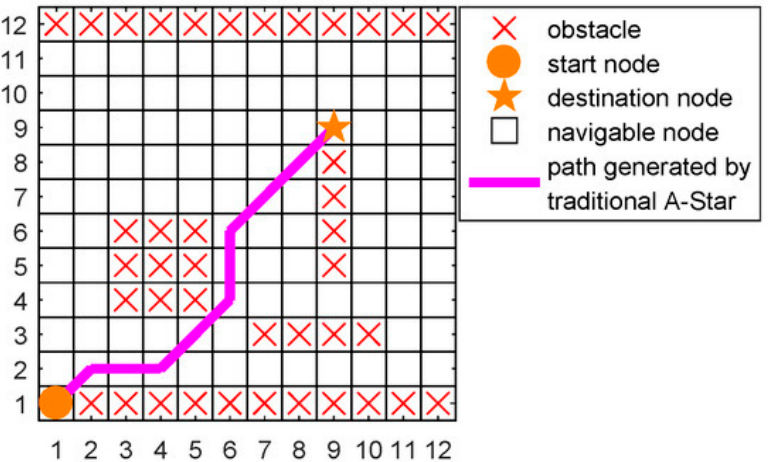
Figure 2. Illustration of A* algorithm [5].